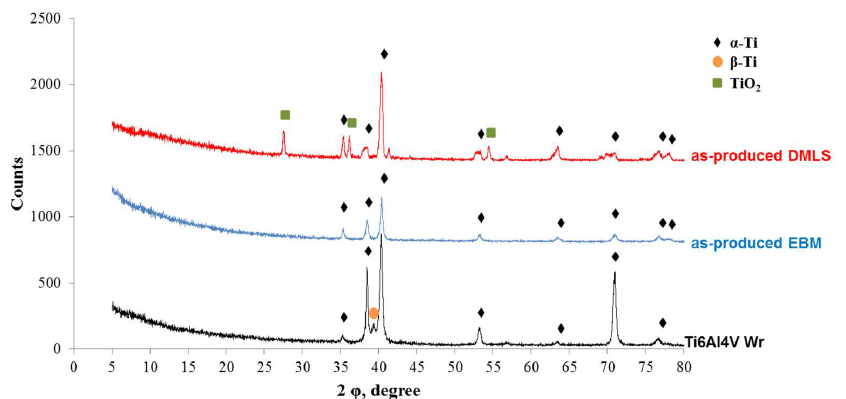
Figure 8. XRD spectrum of Ti-6Al-4V Wr (black line), as-produced EBM (blue line) and as-produced DMLS (red line) specimens.